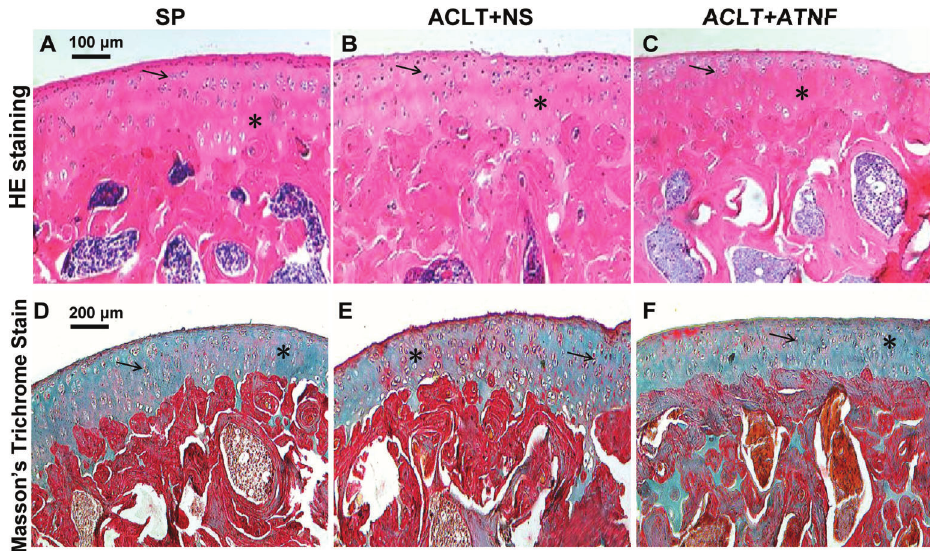
Figure 2. Histological comparison of articular cartilage fi ndings at the distal femur by hematoxylin and eosin (HE) staining (magni fi cation 200 (cid:2) ) and cartilage matrix morphology fi ndings by Masson ’ s trichrome staining (magni fi cation 100 (cid:2) ). A , D , sham-operated (SP) group; B , E , anterior cruciate ligament transection (ACLT) + normal saline (NS) group; C , F , ACLT + anti-tumor necrosis factor- a antibody (ATNF) group. In the ACLT + NS group, the cells had an irregular arrangement. In the ACLT + ATNF group, the cells re-established an ordered pattern and the cartilage matrix was slightly and unevenly stained. Arrows indicate the cells. Asterisks represent the cartilage matrix.